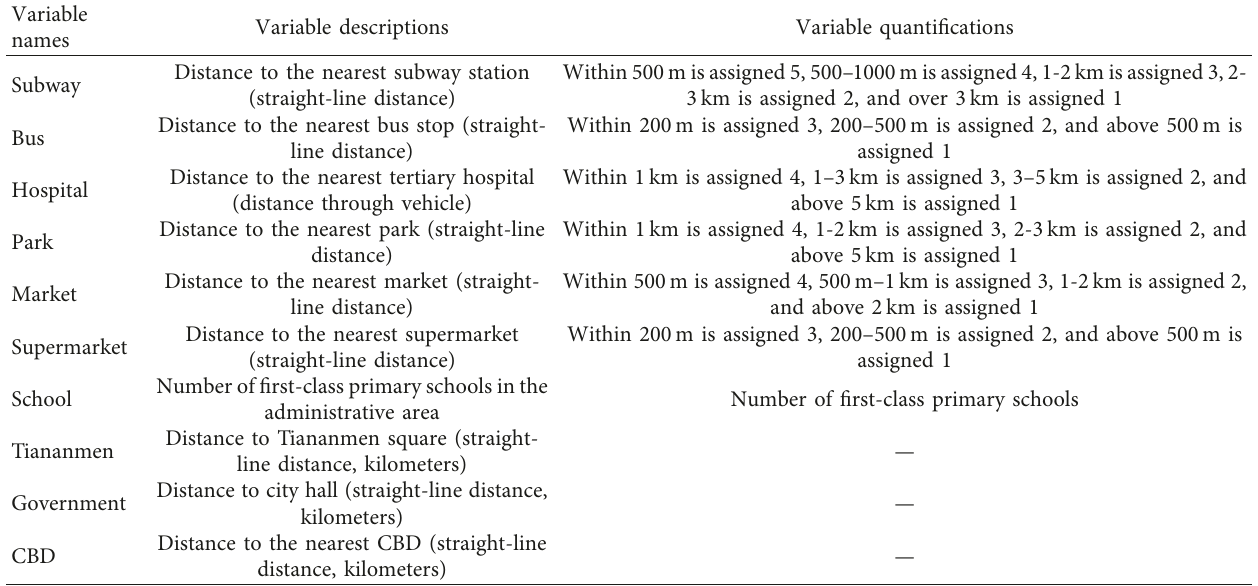
Table 1: The mesodimensional control variables and their quantification.